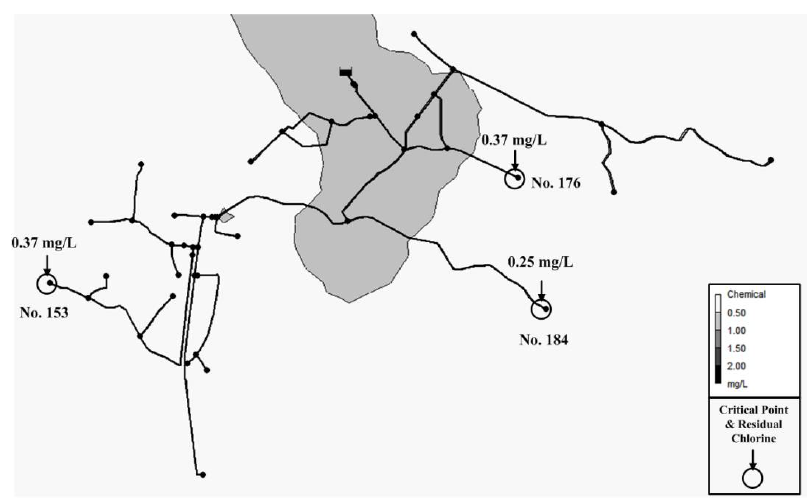
Figure 3. Spatial distribution of residual chlorine for network 2.